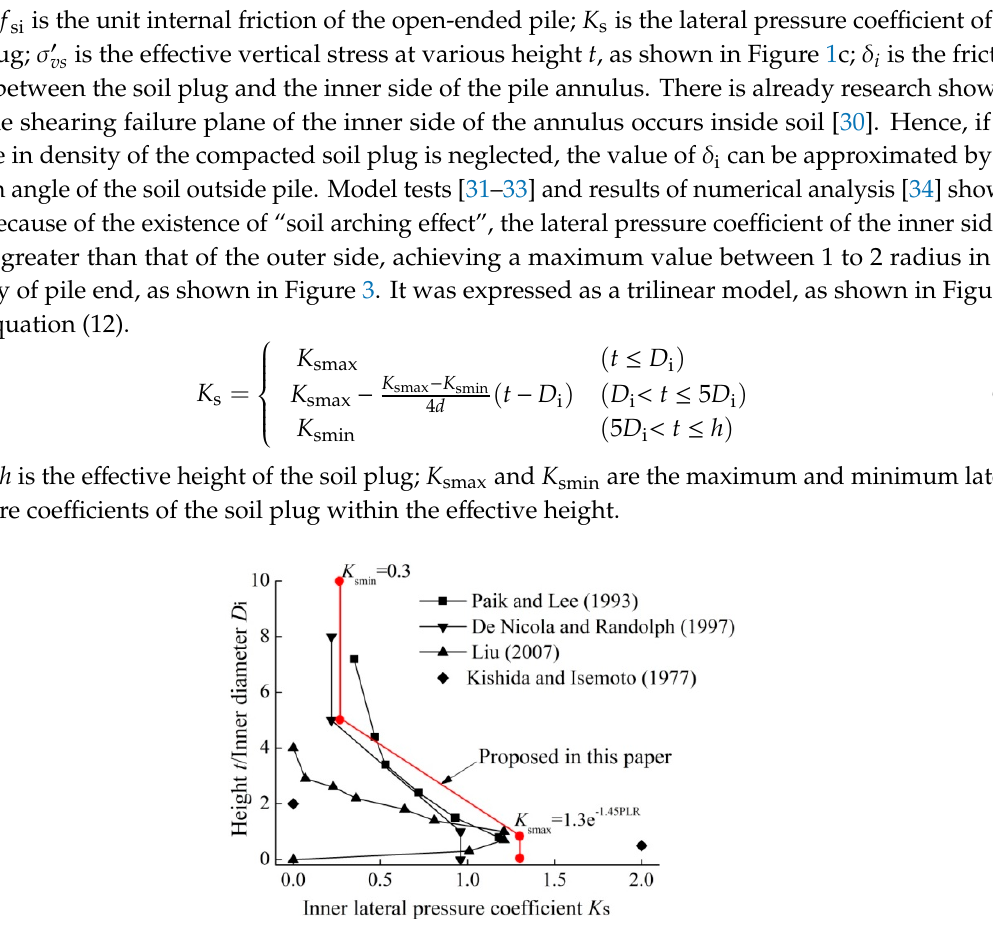
Figure 3. Trilinear model for the distribution of lateral pressure coefficient for the soil plug.